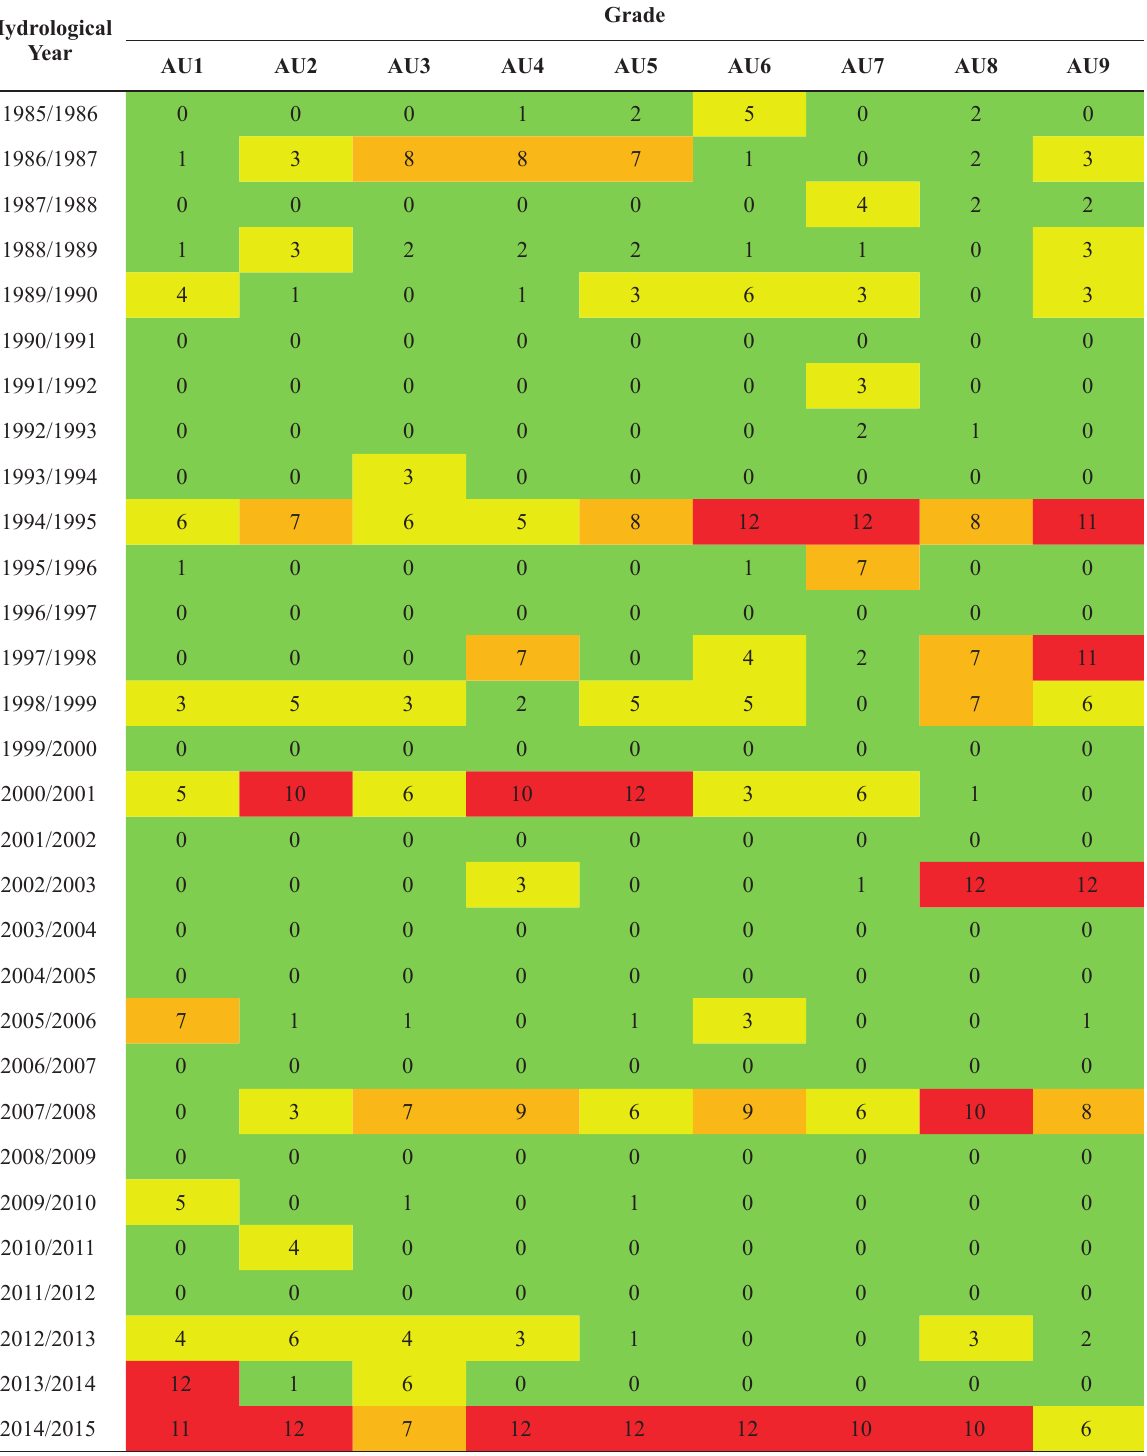
Alert classification of the AUs of the Doce River Basin from 1985 to 2015 based on the global classification. Hydrological